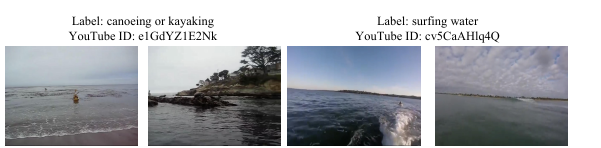
Figure 6. The examples of Kinetics400 in which it is difficult for skeleton-based methods to handle human action recognition tasks. The people are in small regions, or there are no people in frames.